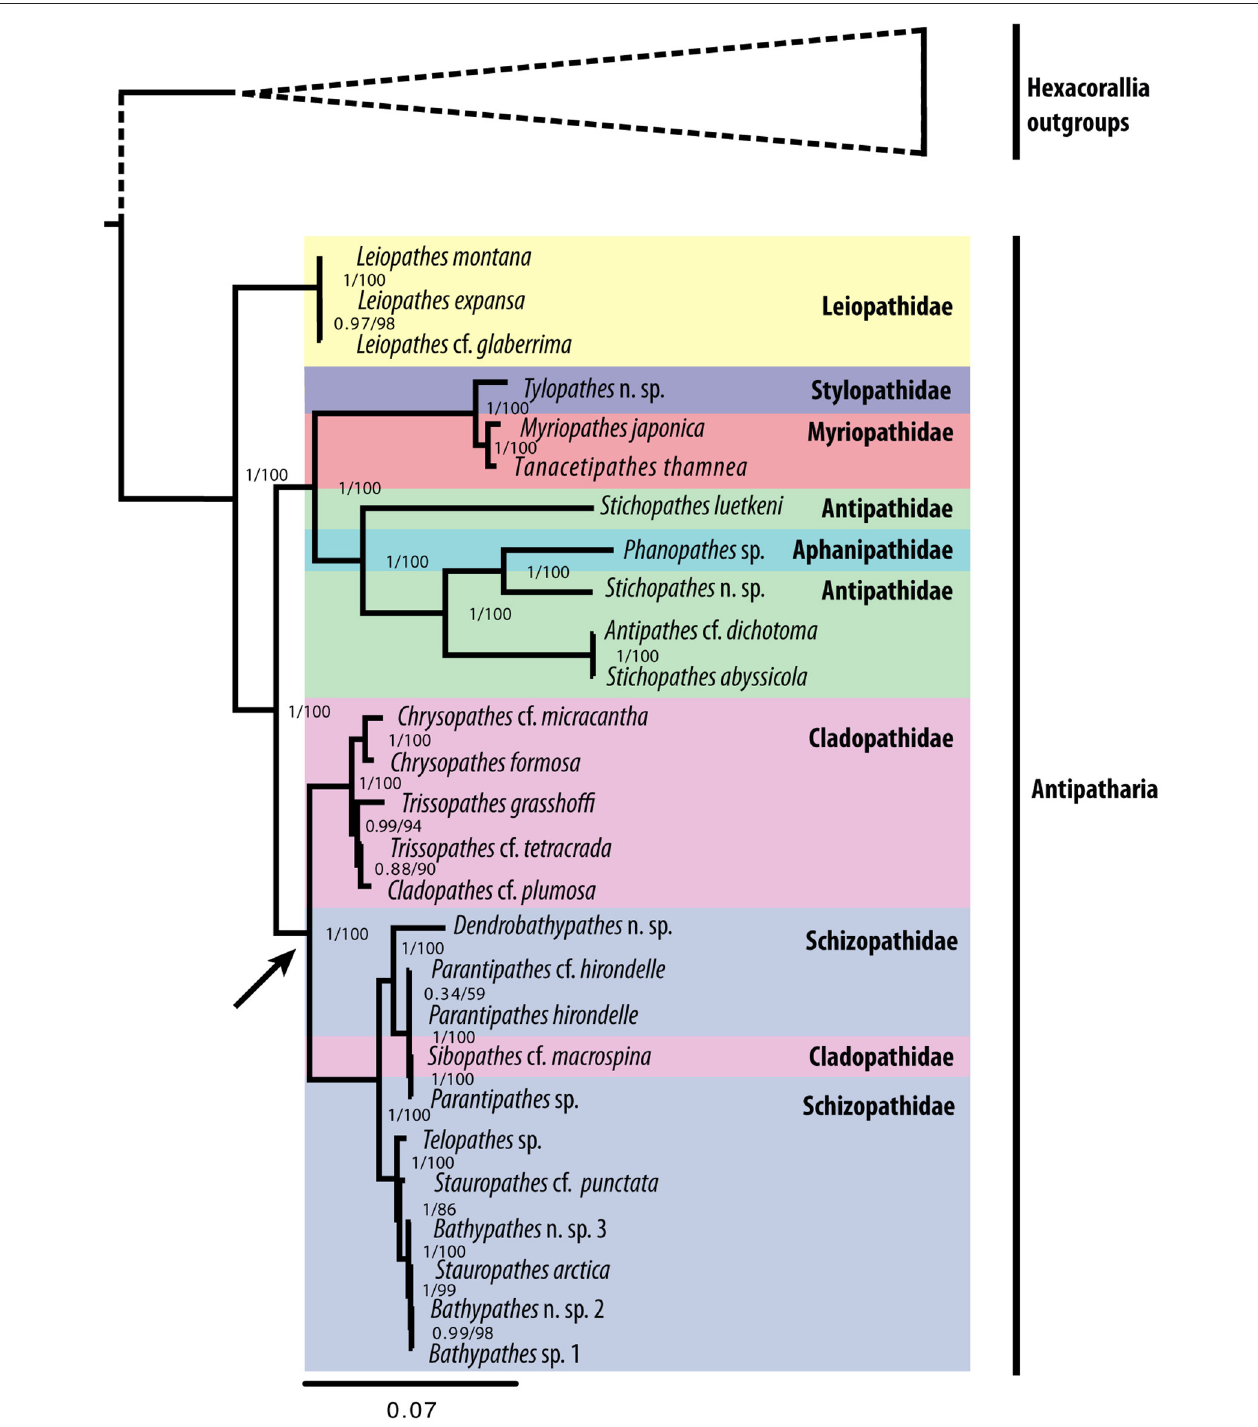
FIGURE 3 | Phylogenetic tree reconstruction based on all available (newly sequenced from this study and GenBank samples) antipatharian mitochondrial genomes using the 13 energy pathway genes based on a Bayesian inference (BI) and maximum likelihood (ML) analysis. The trees are rooted at a midpoint between Antipatharia and the hexacoral outgroups (See Figure S1 for outgroup relationships). BI posterior probabilities and ML bootstrap values shown at nodes (BI/ML). The arrow indicates the apparent loss of the COX1 intron at an internal node.